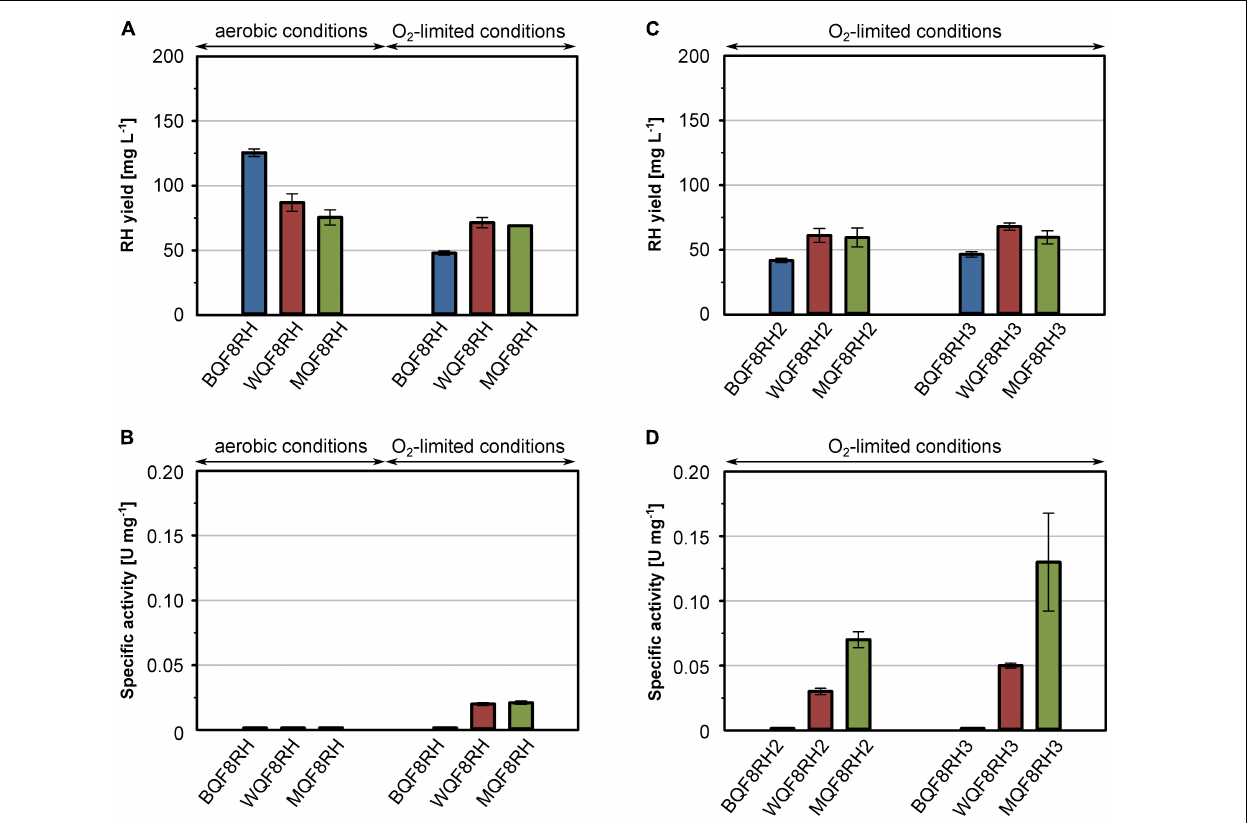
FIGURE 1 | Comparison of production strains, cultivation mode and hyp gene co-expression for heterologous RH production. E. coli strains BQF8RH, WQF8RH and MQF8RH (derivatives of E. coli strains BL21 Gold, W3110 and MC4100, respectively) carry plasmid pQF8 encoding the two RH subunits were used. For co-expression of the maturation genes of C. necator , strains BQF8RH, MQF8RH and WQF8RH were transformed with either plasmid pQF12 (encoding the entire hyp1 operon) or plasmid pQF13 (encoding the modified hyp1( (cid:49) F1) operon lacking hypF1 ) yielding strains BQF8RH2, WQF8RH2 or MQF8RH2 and BQF8RH3, WQF8RH3 or MQF8RH3, respectively. All strains were cultivated in 50 mL EnPresso B medium as described in section “Materials and Methods.” For aerobic production, cultivation was performed in 250-mL Ultra Yield flasks (20% V/V) shaken at 250 rpm, whereas O 2 -limited production was performed in 125-mL PreSens flasks (40% V/V) adjusted to a DO near 0% by manually decreasing the shaking speed. RH protein was purified by affinity chromatography (A,C) and specific activities measured from the purified samples (B,D)